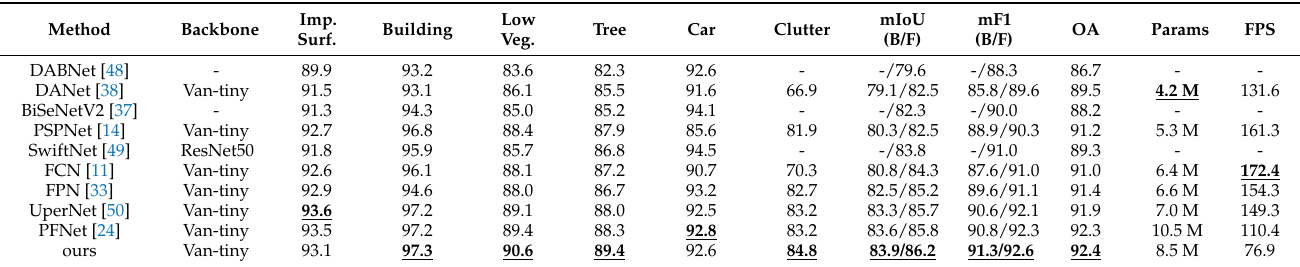
Table 8. Quantitative comparison of experiment results on the Potsdam test set with the networks whose backbones are Van-tiny or similar alternatives.